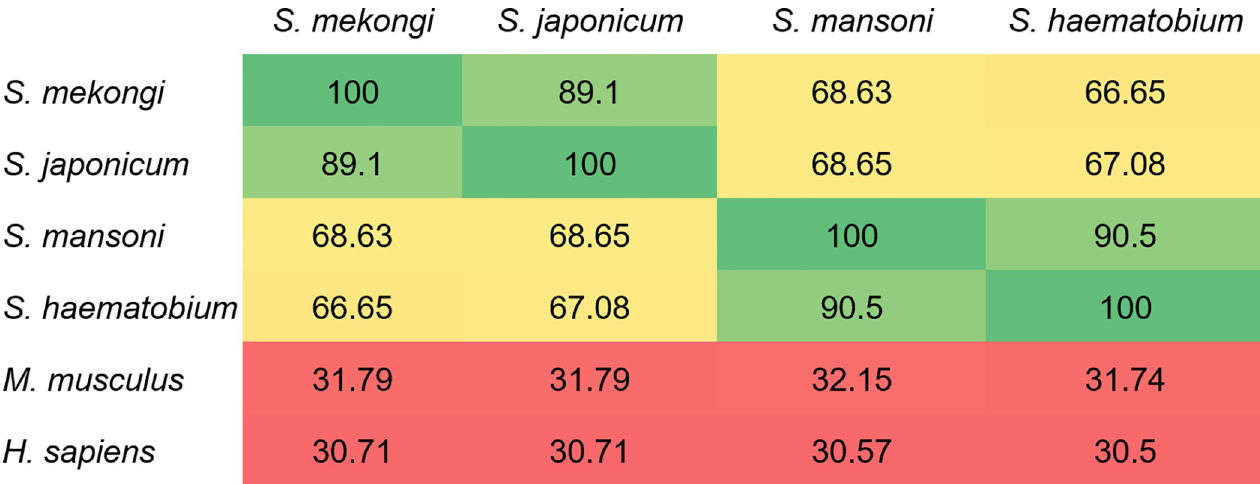
Fig 8. Percentage similarity in protein sequence alignment of putative tuberin among Schistosoma spp., Mus musculus , and Homo sapiens . All protein sequences were obtained from the non-redundant protein sequence databases of NCBI. Sequence alignment and identity calculations were performed using Clustal Omega software. Regions of highest similarity (green), high similarity (yellow), and lower similarity (red) are indicated.